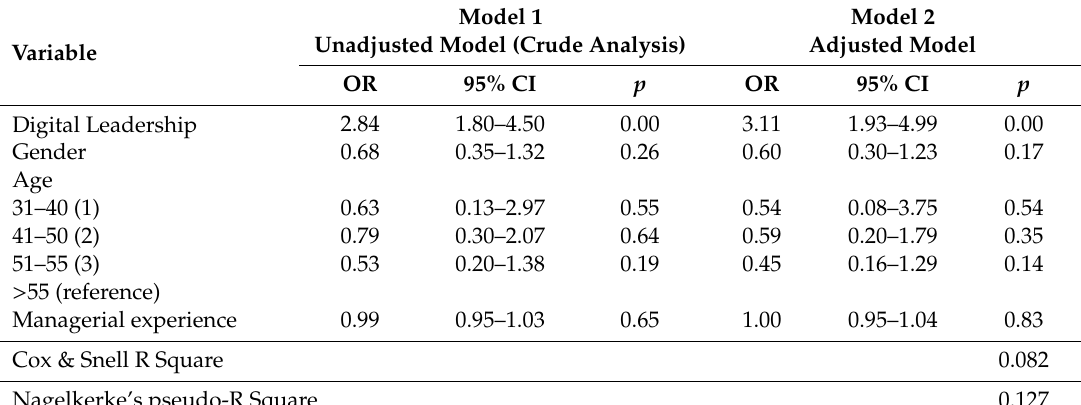
Table 5. Results of the logistic regression